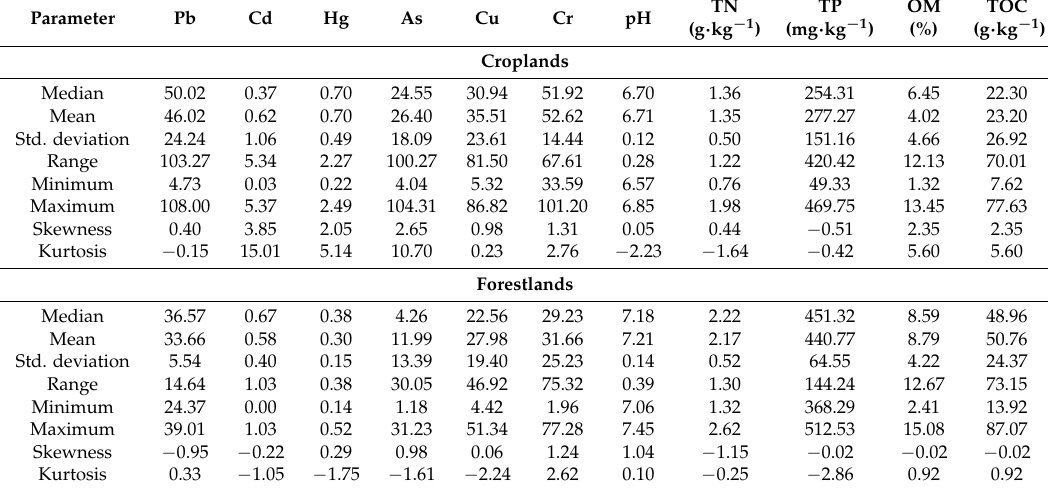
Table 2. Descriptive statistics of the heavy metal concentrations (mg · kg − 1 ) and soil properties of soil samples around the JCFP